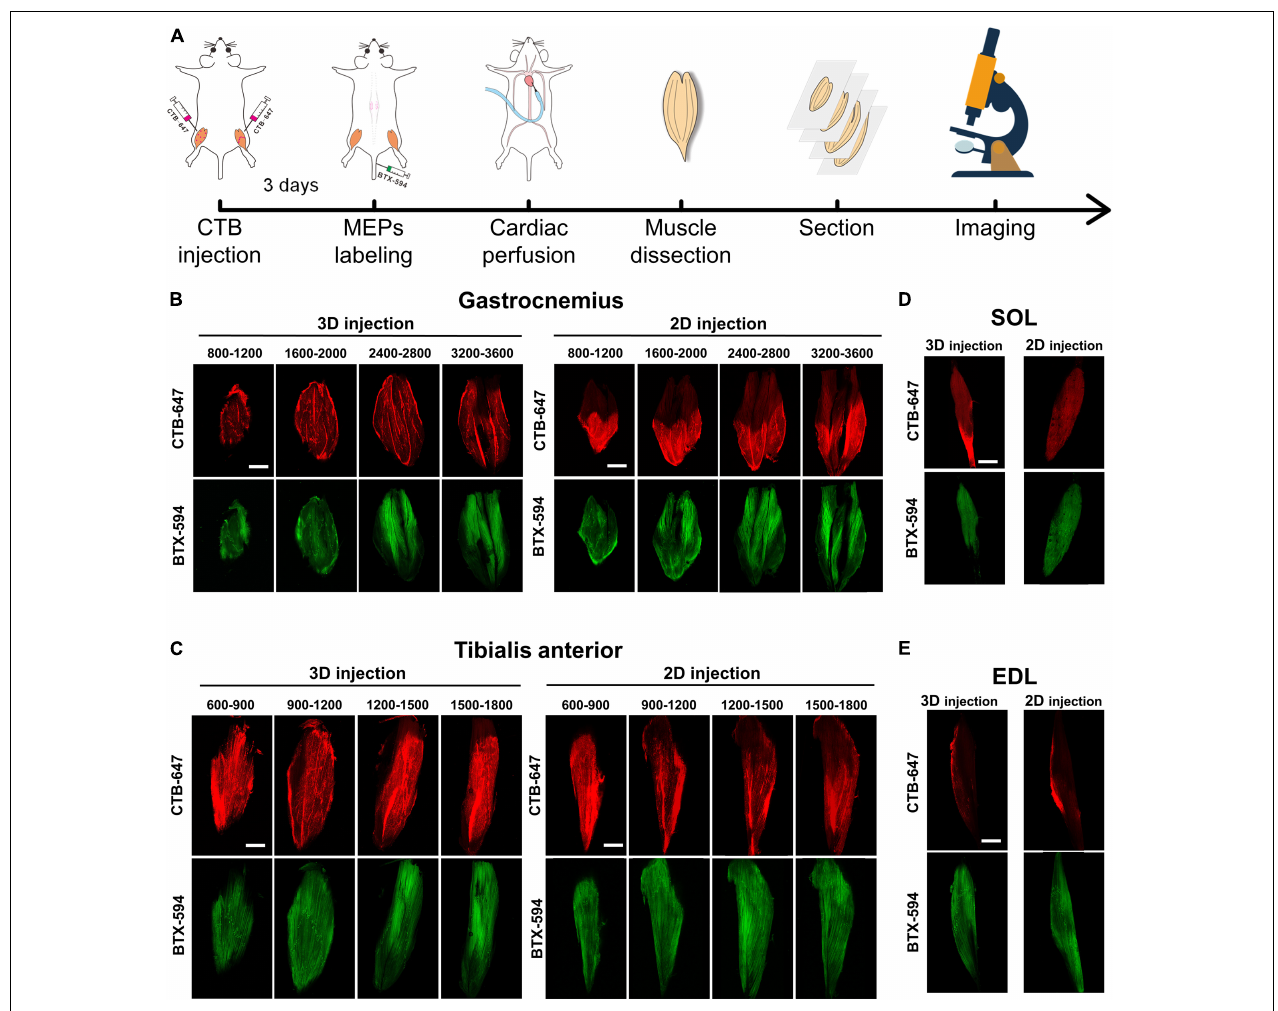
FIGURE 2 | The cholera toxin subunit B (CTB) diffusion and the motor endplate (MEP) distribution in the muscle sections. (A) The entire experiment process of detecting the CTB and the MEPs in the muscle sections. (B,C) The distribution of the CTB and the MEPs at different depths ( µ m) of the gastrocnemius and tibialis anterior after 3D injection and 2D injection. (D,E) Images in the adjacent soleus and extensor digitorum longus. Each image is a maximum intensity projection of the image stacks (60- µ m thickness). Scale bar: 2,000 µ